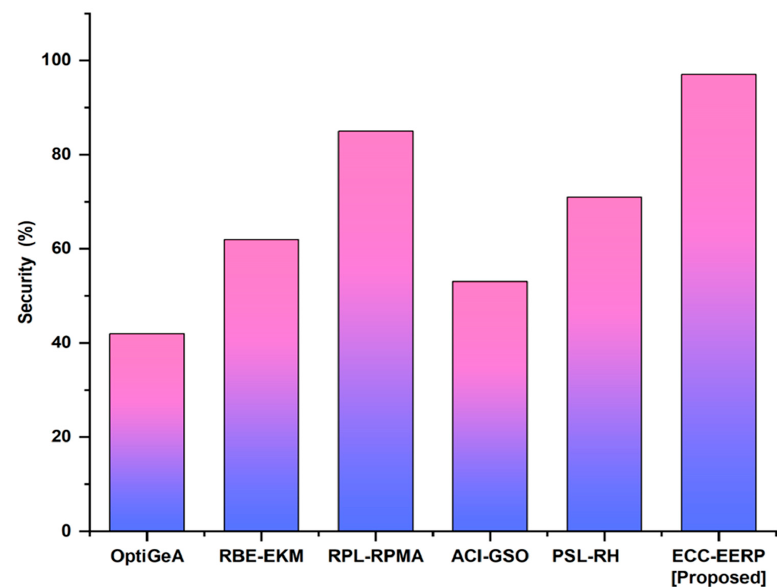
Figure 4. Security of the proposed and existing methods [41–45]. Table 3. Security of the proposed and existing methods .